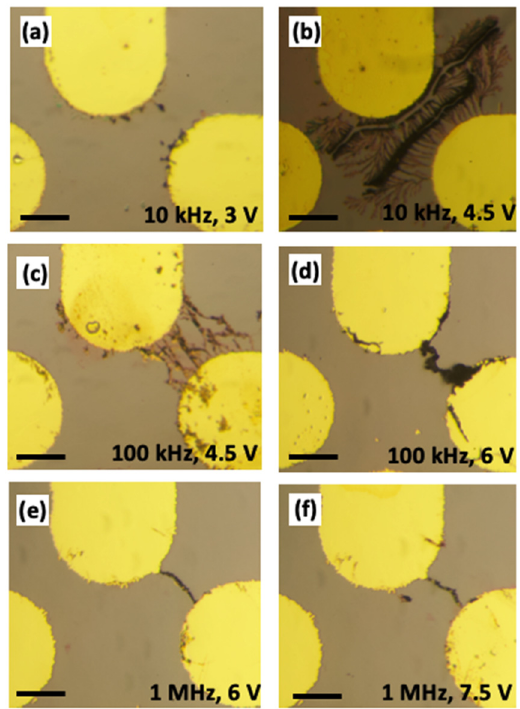
Figure 1. Gold nanostructures assembled at various electric field conditions. In all images, the top and right electrodes were activated with an AC potential. ( a ) 10 kHz, 3 V amplitude. ( b ) 10 kHz, 4.5 V amplitude. ( c ) 100 kHz, 4.5 V amplitude. ( d ) 100 kHz, 6 V amplitude. ( e ) 1 MHz, 6 V amplitude. ( f ) 1 MHz, 7.5 V amplitude. The scale bar represents 40 μ m.